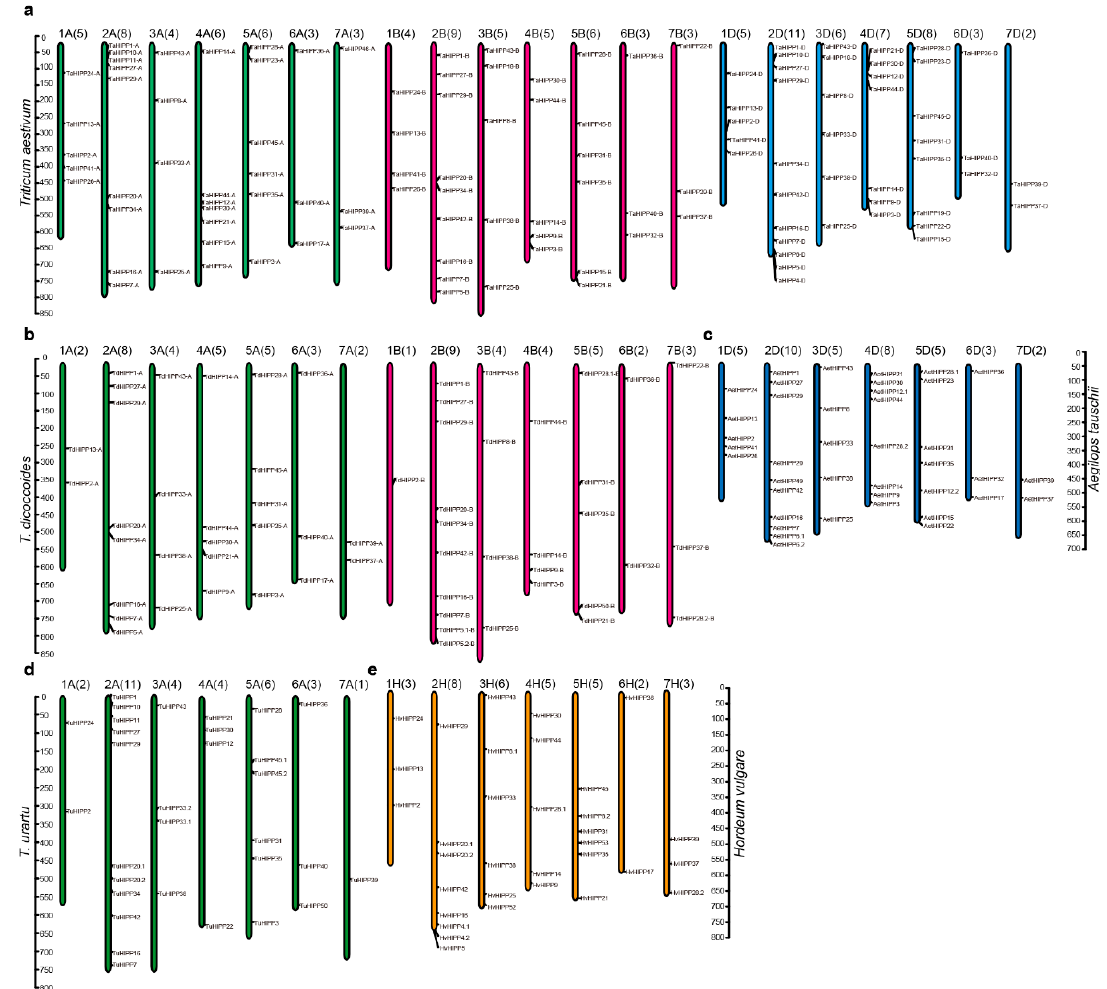
Figure 3. Chromosomal distribution of the HIPPs in the five Triticeae species. The chromosomal distribution of the HIPP genes in T. aestivum ( a ), T. dicoccoides ( b ), Ae. tauschii ( c ), T. urartu ( d ), and H. vulgare ( e ). The identities of the chromosomes are indicated at the top of each chromosome—the number in brackets corresponds to the number of genes located on the corresponding chromosome, while the HIPP gene names are shown to the right of each chromosome. Ta: T. aestivum ; Tu: T. urartu ; Aet: Ae. tauschii ; Td: T. dicoccoides ; Hv: H. vulgare